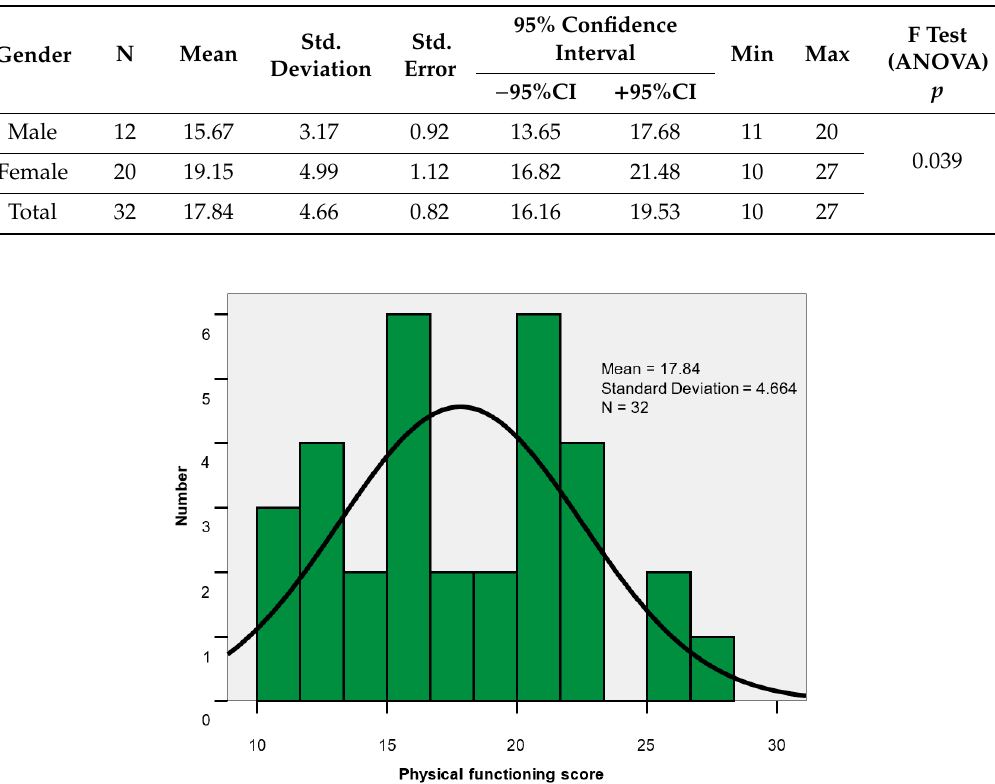
Figure 4. Physical functioning score histogram.